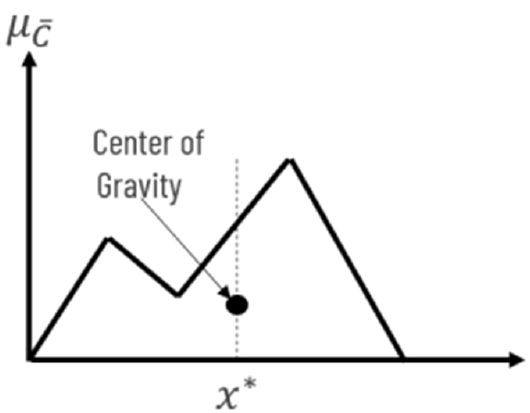
Figure 10. Defuzzification using CG method.